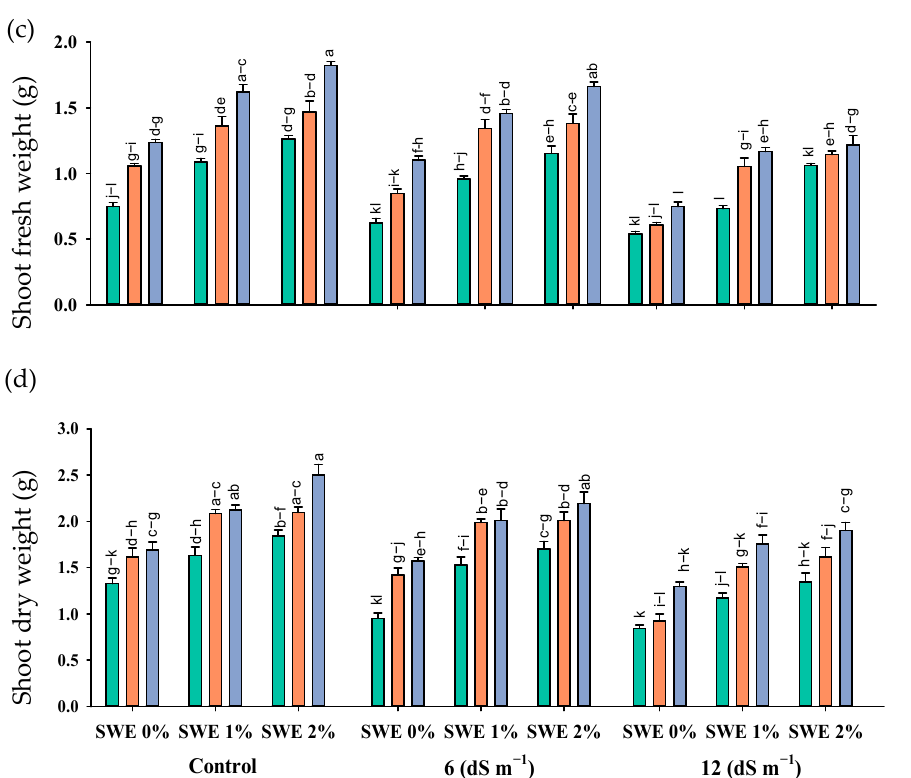
Figure 1. Root fresh weight (g; a ), shoot fresh weight (g; b ), root dry weight (g; c ), and shoot dry weight (g; d ) of maize as affected by various treatments of vermicompost (VC), sorghum water extract (SWE) under control, moderate salinity (6 dS m − 1 ) and high salinity (12 dS m − 1 ). Error bars depict the standard error of 3 replications ( n = 3). Bars with the same letters do not differ significantly ( p ≤ 0.05).